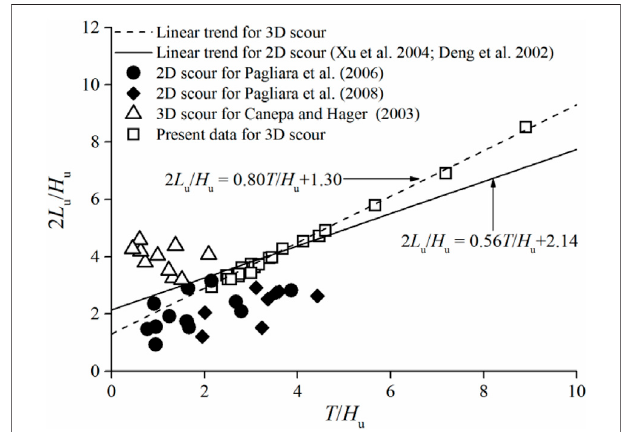
FIGURE 10 | Comparison of morphology between three- and two- dimensional scours.